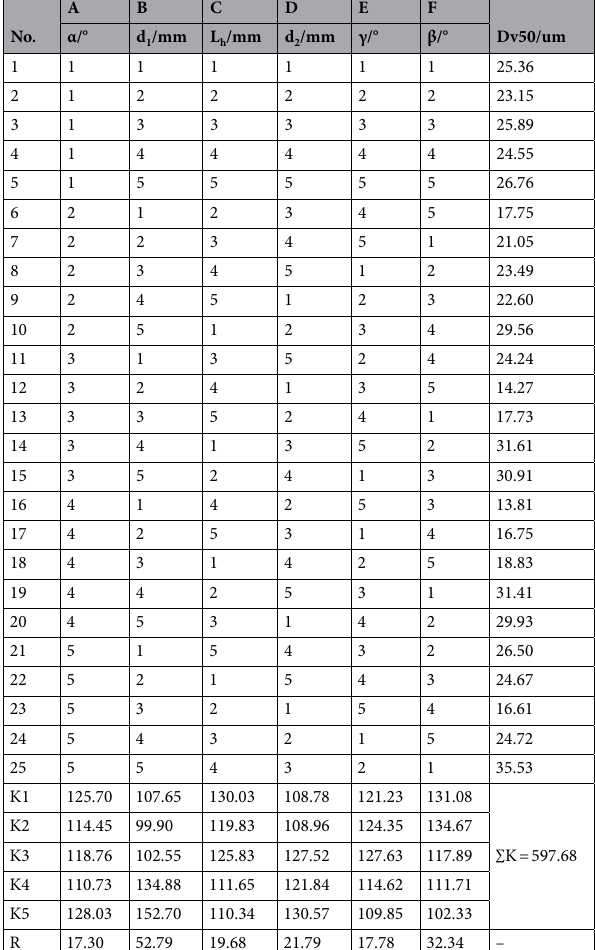
Table 2. The orthogonal test